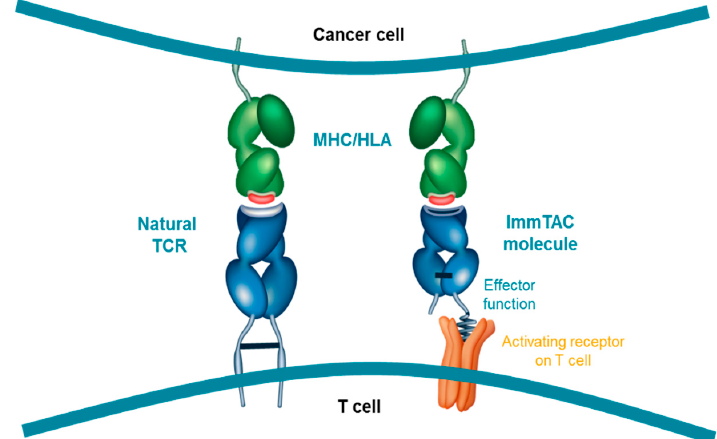
Figure 2. ImmTAC molecules are designed to mimic the natural immune synapse formed by interaction of a TCR with a peptide-human-leukocyte-antigen (pHLA) complex. The anti-CD3 effector function attracts and binds to CD3 receptors (activating receptor) on T cell surfaces triggering T-cell mediated cancer cell lysis; HLA, Human leukocyte antigen; MHC, Major histocompatibility complex; TCR, T cell receptor.